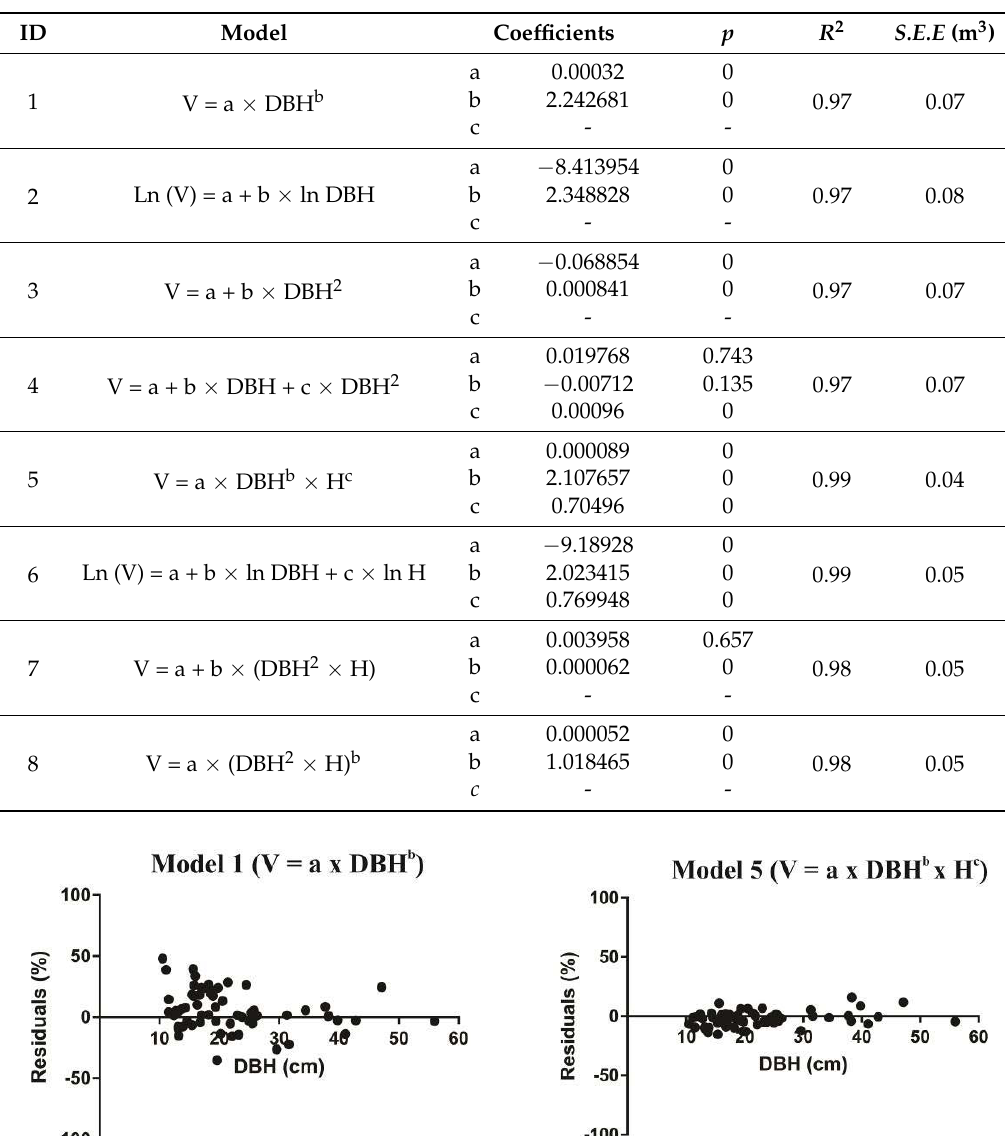
Table 3. Estimated coefficients of tested models using 64 sample trees of Eschweilera genus and their respective statistics: p -value, R 2 , and standard error of estimate ( S.E.E ).